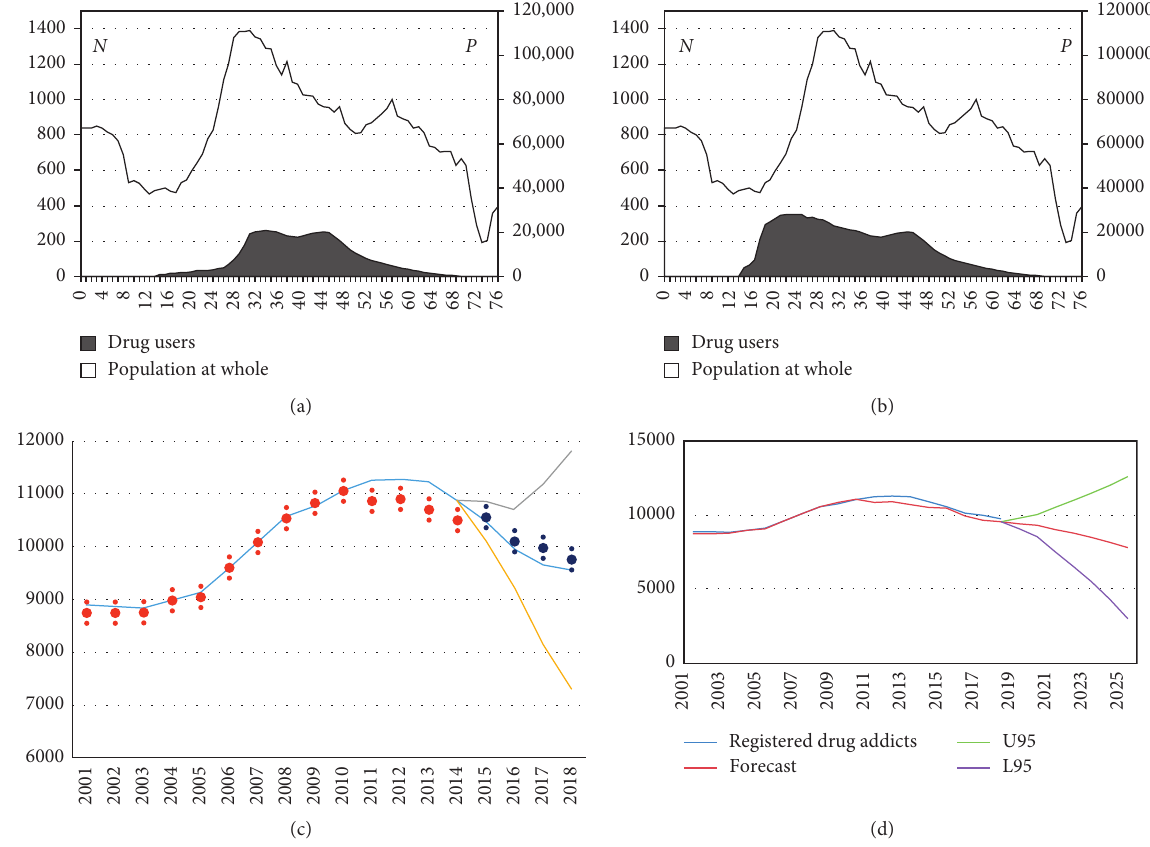
Figure 10: Drug addiction probability forecasting in St. Petersburg until 2020, taking into account the emotional and psychological state of the population, in the (a) optimistic scenario I historical data up to 2014. (d) Forecast of the number of drug addicts of all